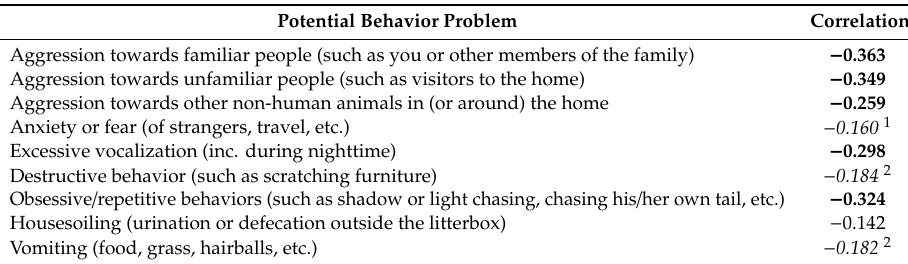
Table 5. Correlations (Spearman’s) between owner knowledge (higher score reflects more accurate understanding of cat behavior) and tolerance for undesirable behaviors exhibited by their cat (higher score indicates that the owner is more bothered by this behavior). Owners who reported that their cat did not exhibit the behavior were removed from this analysis; response options ranged from 2 (“My cat does exhibit this behavior, but I’m not bothered by it at all”) to 5 (“My cat does exhibit this behavior, and it bothers me a great deal”). Bold font indicates that the correlation is significant from 0 at p < 0.0001; italic font indicates that the correlation is significant but at a di ff erent level; see footnotes for these p